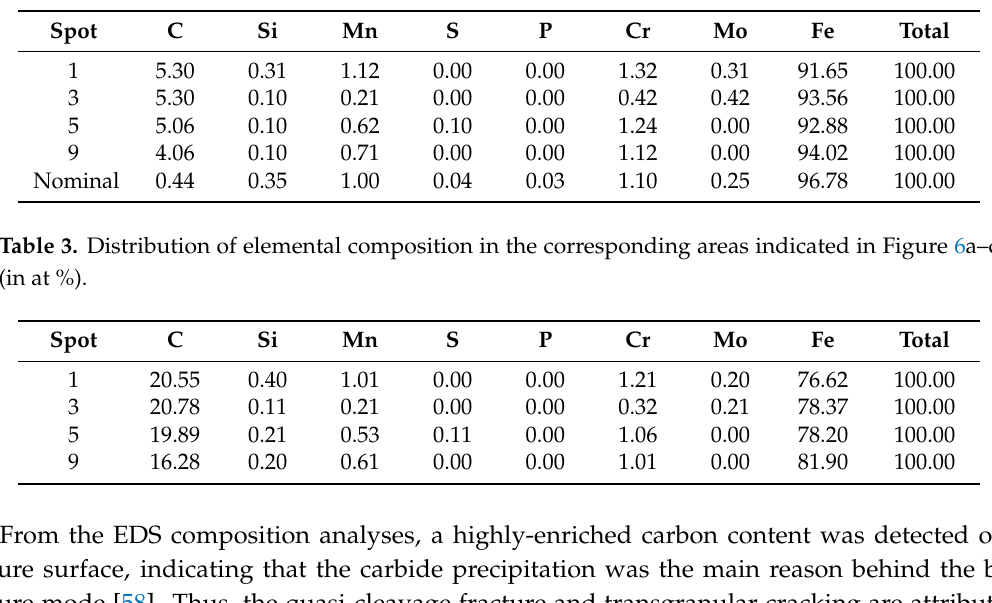
Figure 6. ( a – c ) SEM micrographs of the fracture surface (transgranular cleavage areas) for the EDS spot analyses. Table 2. Distribution of elemental composition in the corresponding areas indicated in Figure 6a–c (in wt %).